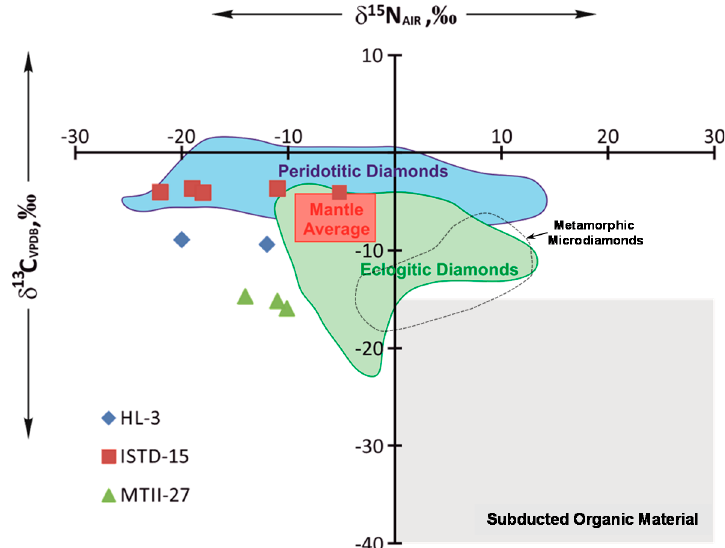
Figure 3. Carbon ( δ 13 C VPDB ) and nitrogen ( δ 15 N AIR ) isotope compositions of yellow cuboid diamonds from alluvial placers in the northeastern Siberian platform and comparison with peridotitic and eclogitic diamond data worldwide [3] and metamorphic microdiamonds [31]. Average mantle range and range of subducted organic material for δ 13 C and δ 15 N values are also shown [3].